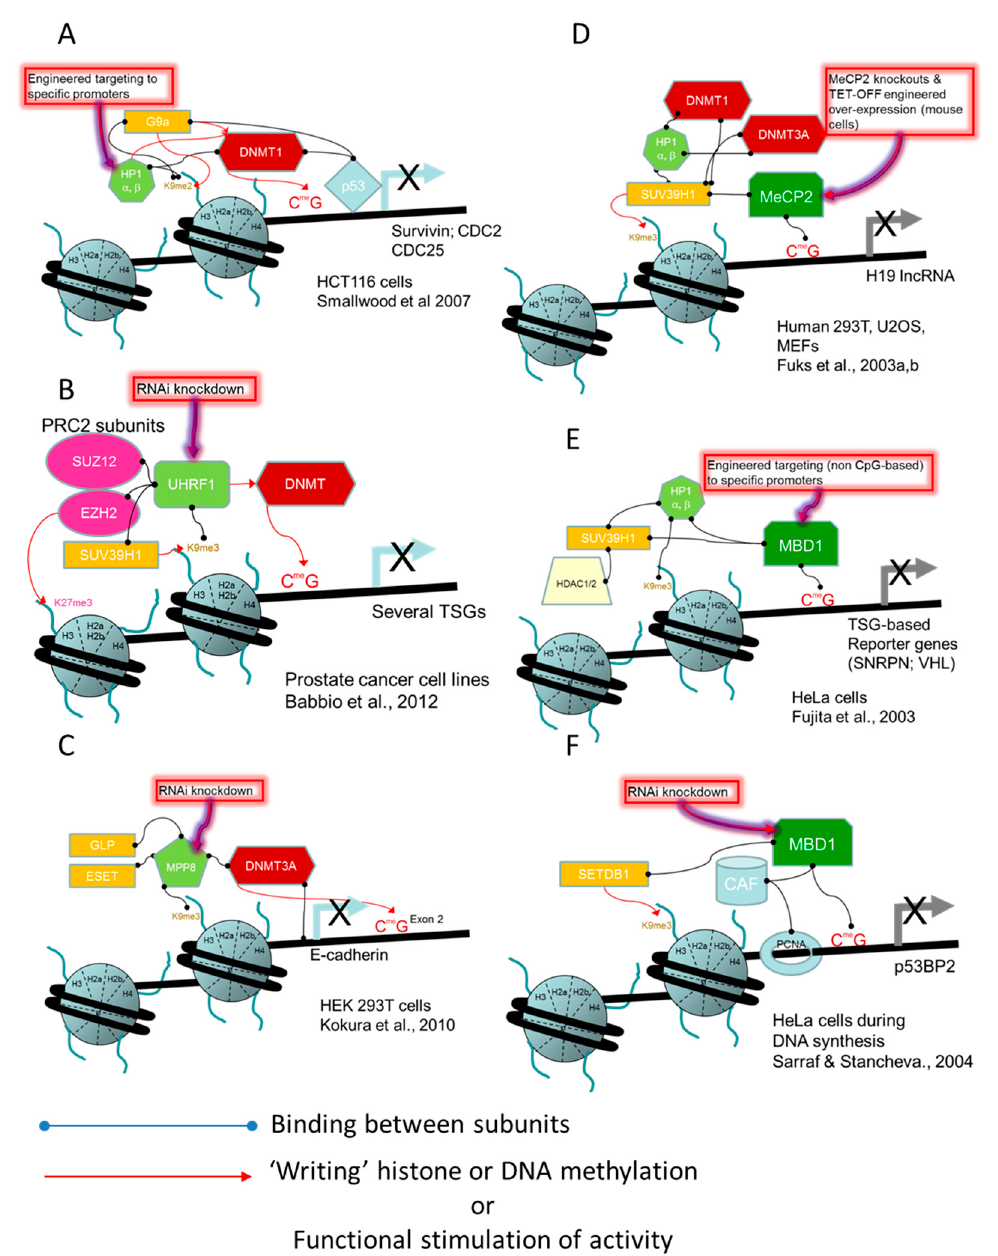
Figure 6. ( A – C ) Schematic models depicting “bridge” proteins (green boxes, HP1, UHRF1, MPP8) connecting H3K9 histone methylation to H3K9 methylation writers (orange rectangles) and to DNA methyltransferases in segments of DNA controlling tumour suppressor gene silencing (X over transcription unit, (cid:31) , indicates inhibited transcription). Models in ( D – F ) depict the tethering of H3K9 histone methylation writers to methylated segments of DNA in TSG s via methylated DNA binding and “bridge” proteins (dark green boxes, MeCP2 and MBD1). Experimental interventions are indicated in the Red Boxes within each schematic. Several forms of evidence were presented for the interactions of components in each model, as indicated by the types of connectors at the bottom of the figure.